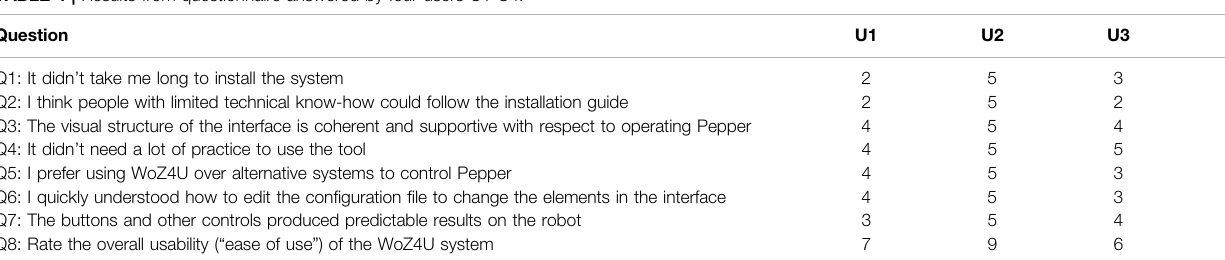
TABLE 4 | Results from questionnaire answered by four users U1-U4.